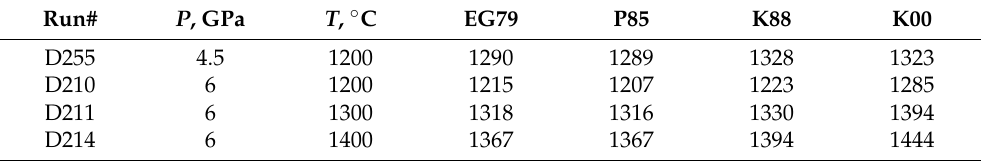
Table 9. Temperature estimates using Cpx-Grt geothermometers in the system L(S) + L(C). Run# P , GPa T , ◦ C EG79 P85 K88 K00 D255 4.5